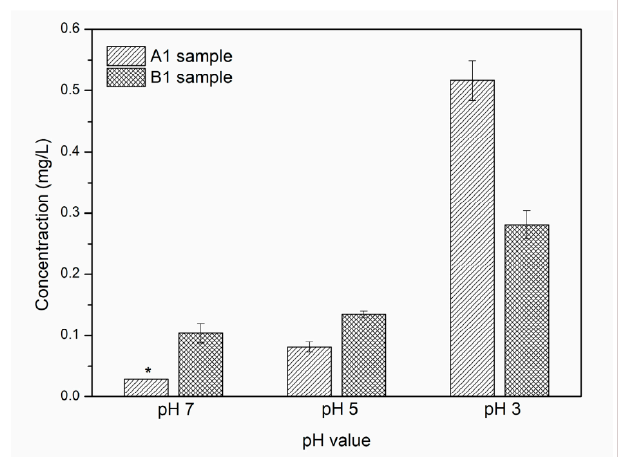
Figure 10. Cumulative concentrations of Ag ions released from chit/EE100/AgNPs coatings (A1 and B1 samples) after 1 day of exposure in SBF solution of different pH values at 39 ◦ C. Data were reported as mean ± SD ( n = 8); * the measured value was below the LOD (limit of detection) < 0.013 mg/L. The minimum requirement for antibacterial activity of silver is at concentrations of at least 0.1 ppb [71]. In addition, the dose of allowable silver oral exposure determined by the United States Environmental Protection Agency (US EPA) equals 0.005 mg Ag/kg